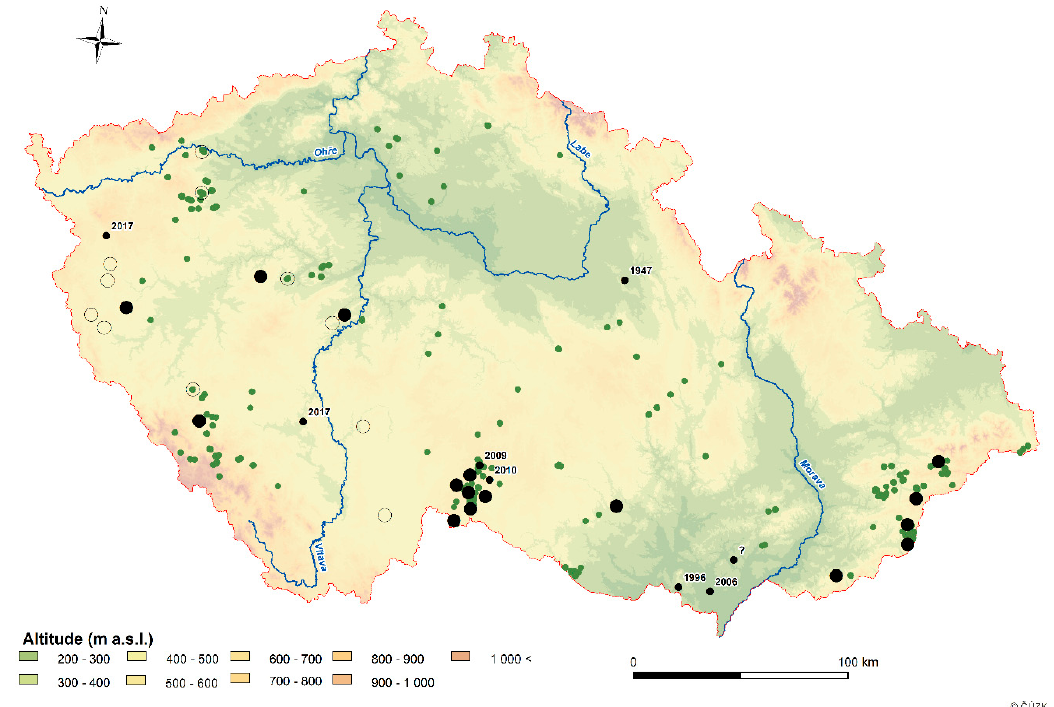
Figure 1. Occurrence of Phloeosinus aubei in the Czech Republic. Positive detections as documented in records before 2017 are indicated by small black circles (with detection year), and positive detections in 2018 are indicated by large black circles. Negative detections in 2018 are indicated by empty circles. Small green circles indicate juniper habitats (T3.4A, T3.4B, T8.1A, and T8.2A) according to Natura 2000 mapping in the Czech Republic (see Materials and Methods for details).